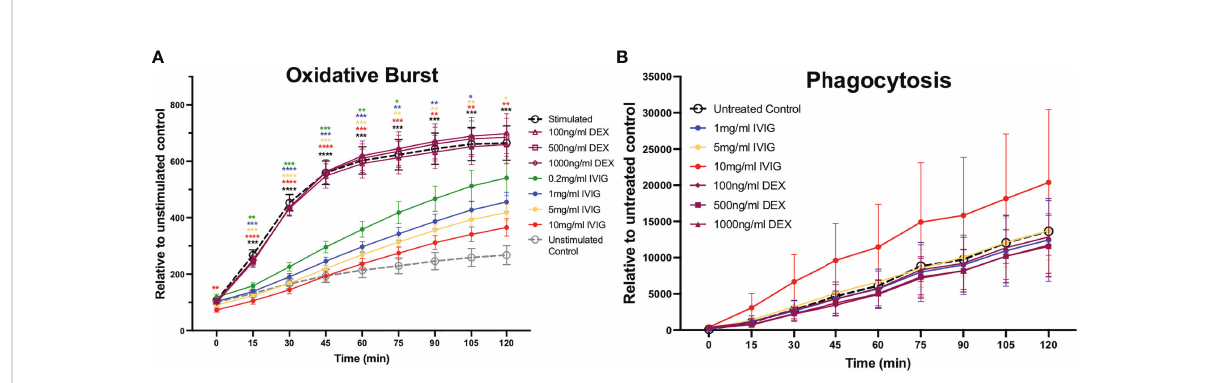
FIGURE 2 Treatment of primary human neutrophils with IVIG inhibits oxidative burst in a dose-dependent manner, while preserving phagocytosis. Circulating neutrophils from healthy controls were used to assess antimicrobial functions including reactive oxygen species production (oxidative burst) and phagocytosis. (A) Neutrophil oxidative burst, while being an important antimicrobial function can cause signi fi cant collateral damage to tissues, was inhibited in a dose-dependent manner by IVIG (solid circle markers) but not by dexamethasone (hollow purple markers). (B) Neutrophil phagocytosis was retained (unaffected) by treatment with IVIG or dexamethasone. Data were analyzed with a 2-way ANOVA with Geisser-Greenhouse correction and Dunnett ’ s multiple comparisons test. Data are presented as individual data points ± SEM with n = 9 and n = 5 individuals per group in oxidative burst and phagocytosis assays, respectively. Error bars represent 95% con fi dence interval. *P < .05, **P < .01, ***P < .001, ****P <